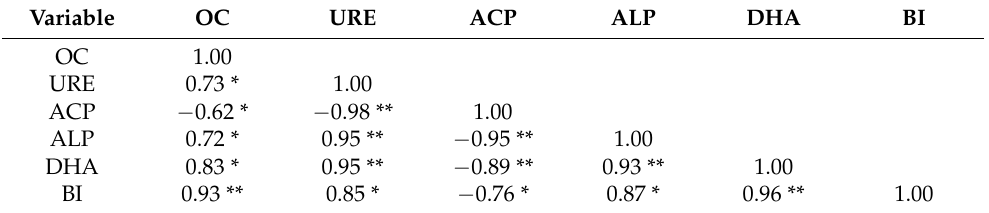
Table 9. Linear correlation coefficients between OC, URE, ACP, ALP, DHA, and BI. Variable